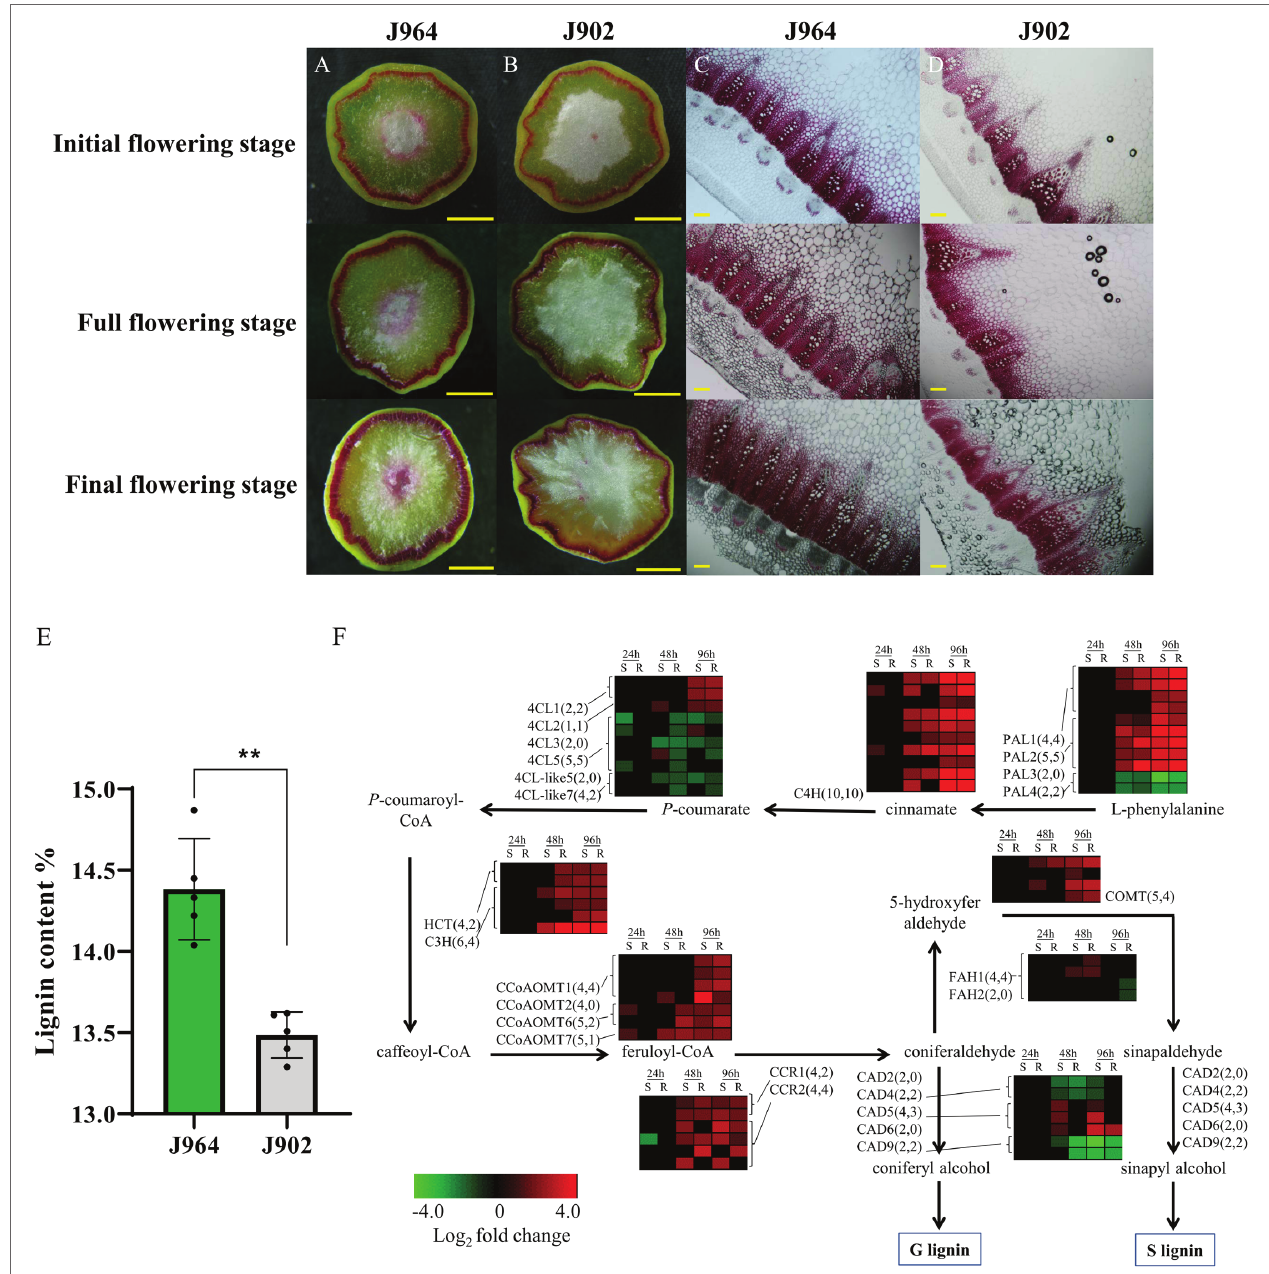
FIGURE 1 | Lignin content and expression of genes related to lignin synthesis in the stems of a Sclerotinia -resistant line (J964) and a Sclerotinia -susceptible line (J902). (A–D) Phloroglucinol-HCl staining of lignin in cross-sections of J964 and J902 stems at different flowering stages. The scale bars represent 1 cm in the whole cross-sections in A-B and 500 μ m in the manually obtained cross-sections in C,D . (E) Percentage of lignin content in the stems of J964 and J902. The values are presented as the means ± SDs of five biologically independent replicates. The asterisks represent statistically significant differences ( ** p < 0.01; Student’s t-test). (F) Whole-genome-wide comparison of genes involved in monolignol biosynthesis pathways in J964 and J902 after S. sclerotiorum infection. The copy numbers of the genes and the differentially expressed genes are listed in square